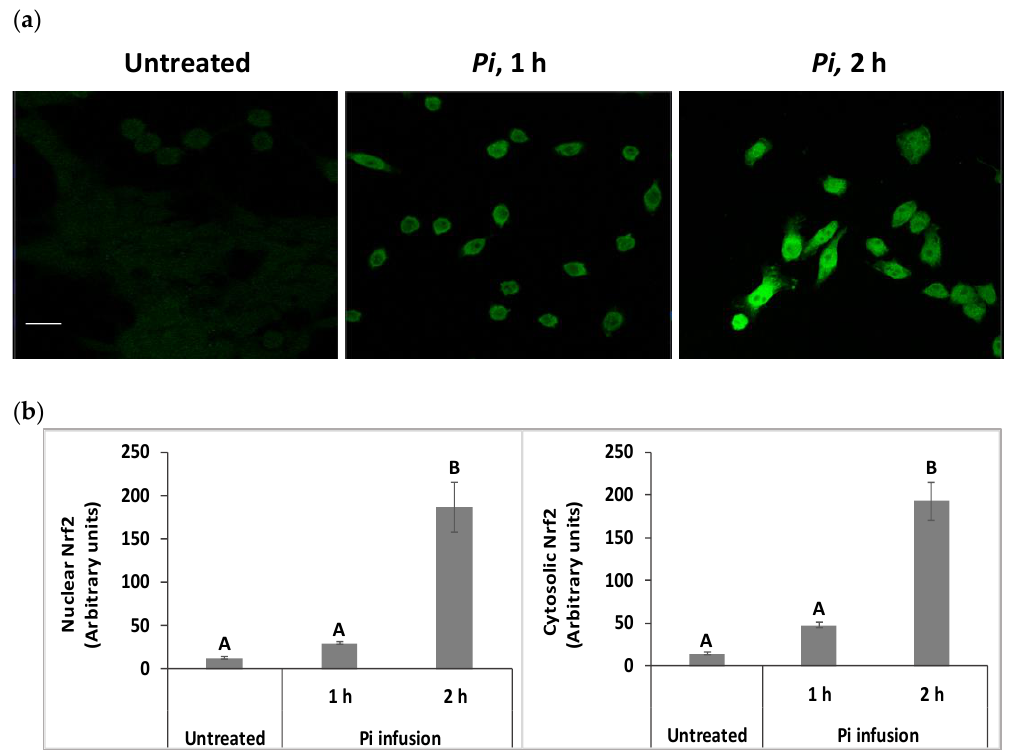
Figure 5. Pi infusion enhances nuclear factor erythroid 2–related factor 2 (Nrf2) expression levels and promotes Nrf2 translocation to the nucleus of neuronal cells. SH-SY5Y cells were treated by Pi infusion (200 µg/mL) for 1 h or 2 h and then immunostained for Nrf2 and nuclei were stained with DAPI. ( a ) Representative images of each treatment from two independent experiments. Each experiment was conducted in duplicates. Bar: 2 0 μm . ( b ) The Image J-measured fluorescence intensities of DAPI were used to normalize nuclear and cytoplasmic Nrf2 fluorescence intensity in 11 different photographed fields. Nrf2 intensity was normalized to DAPI intensity. The results are presented as mean ± SEM ( n = 11) and were analyzed by one-way ANOVA followed by the Tukey – Kramer multiple comparison test. Columns marked with different letters (A, B) represent statistically significant differences ( p < 0.05).